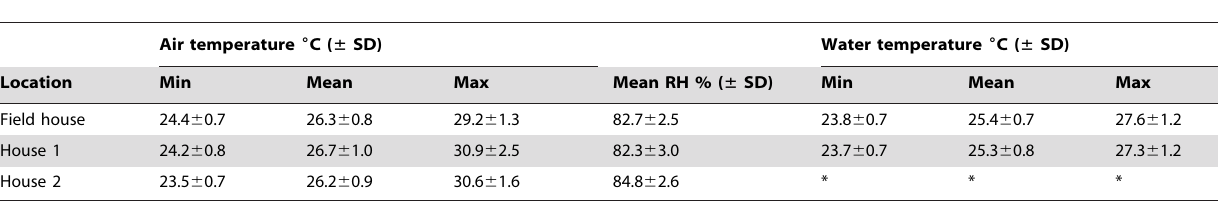
Table 4. Air temperature, relative humidity, and water temperature at three experimental study locations.